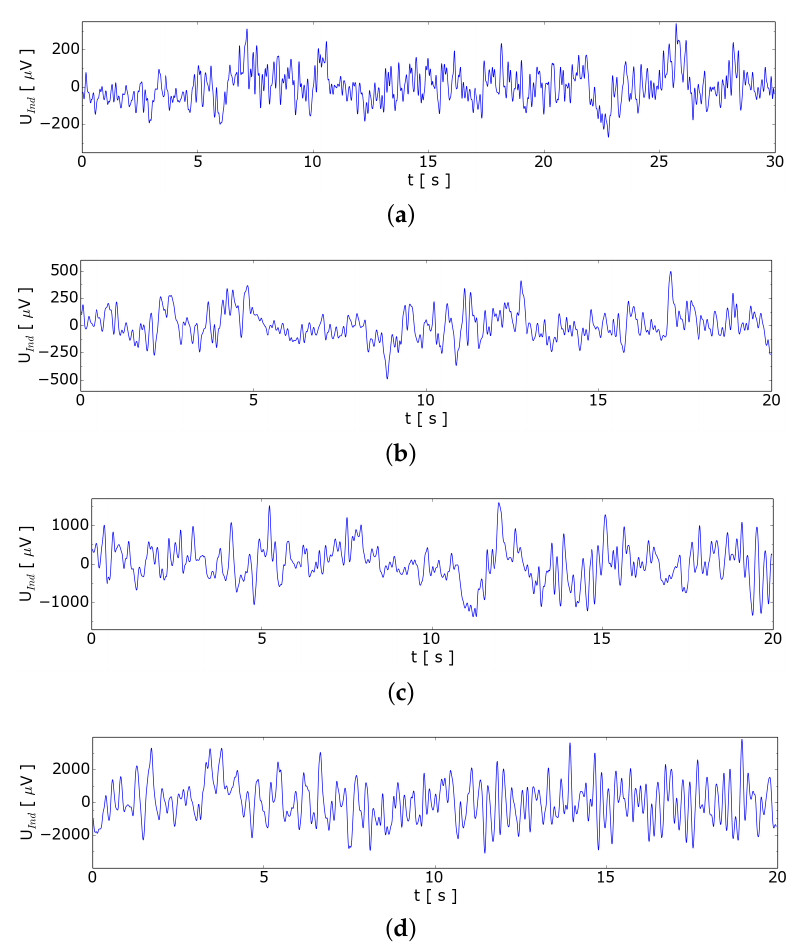
Figure 7. Induced voltage for void fraction analysis. ( a ) 14 sccm—SDEV = 93 µ V; ( b ) 22 sccm—SDEV =